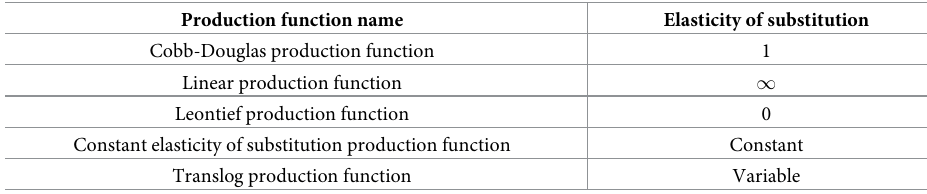
Table 4. Commonly used forms of production